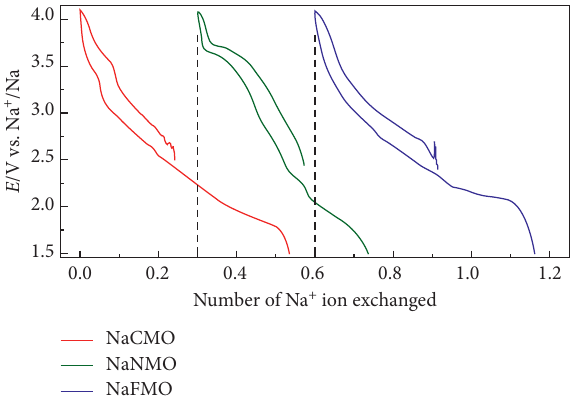
Figure 3: The first galvanostatic charge-discharge of NaCMO, NaNMO, and NaFMO